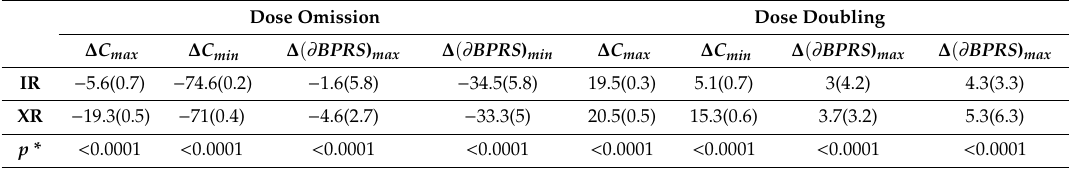
Table 2. E ff ect of Quetiapine dose omission and doubling on changes in PK and PD parameters relative to regular dose administration for the IR and XR formulations. Symbols are defined in